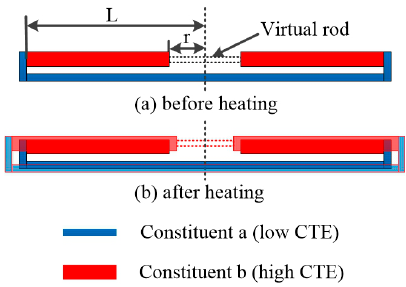
Figure 1. Schematic illustration of the composite rod. ( a ) Structure of the composite rod before heating. It consists of three rods, one long blue rod and two short red rods. The short rods have high coefficient of thermal expansion (CTE), while the long rod has low CTE. The ‘virtual rod’ is the part between the inner ends of the two short rods. ‘L’ is half the length of the long rod, and ‘r’ is half the length of the virtual rod. ( b ) Structure of the composite rod after heating. It shows the deformation mechanism of the composite rod after heating. The theoretical calculation shows that the ‘virtual rod’ could obtain a large magnitude of NTE.